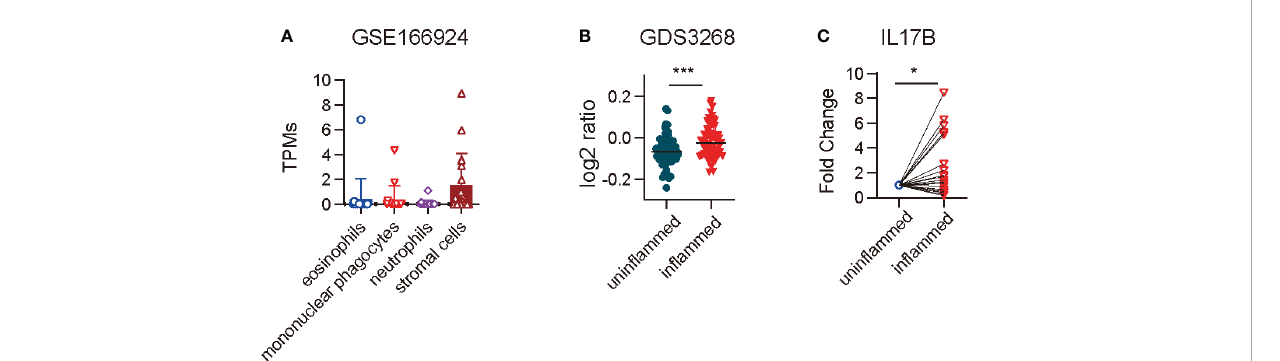
FIGURE 1 IL17B expression was increased in the colon tissue of IBD patients. (A) IL17B expression in different cell types isolated from endoscopic biopsies of patients with IBD in a RNAseq dataset GSE166924. n=17 (B) Quanti fi cation of IL17B expression of colon unin fl amed tissues (n=66) and in fl amed tissues (n=63) from UC patients with a microarray data set GDS3268. *** P < 0.001 determined by student t test. (C) IL17B expression in paired colon in fl amed tissues and non-in fl amed tissues from 23 IBD patients was detected by real-time PCR. Data represent mean ± SD, * P < 0.05; determined by paired student t